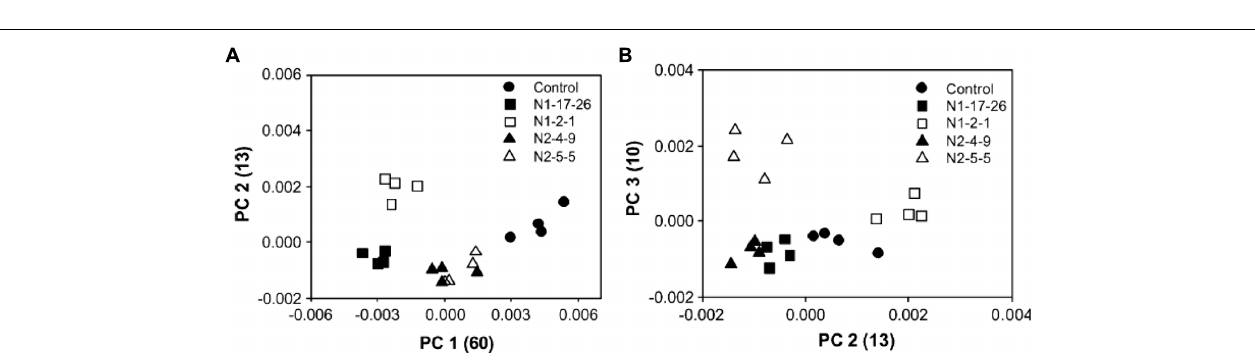
FIGURE 3 | Characteristic mass spectral patterns of primary pyrolysis products for several whole biomass samples and for separated constituents of biomass (Evans and Milne, 1987).